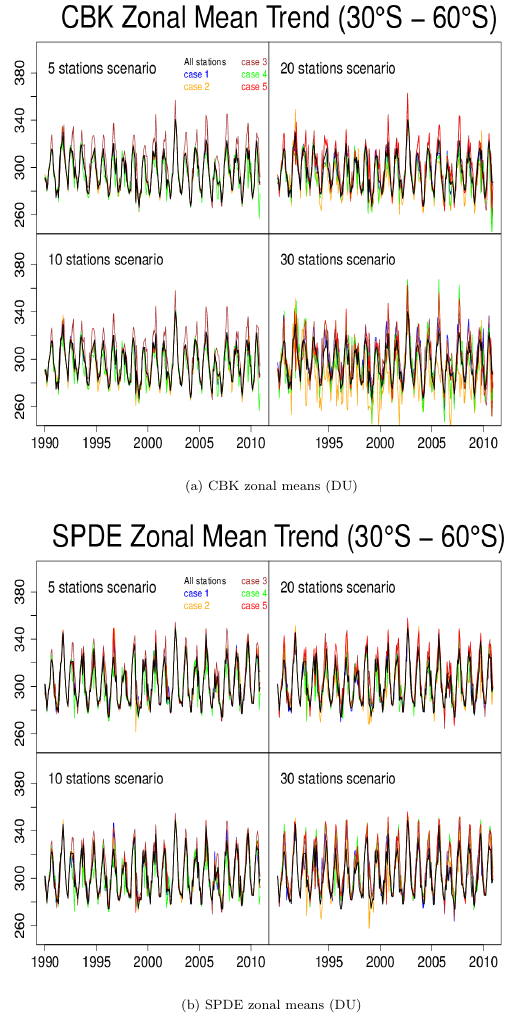
Figure 9. Time series of 30–60 ◦ N zonal means by (a) covariance- based kriging (CBK) and (b) SPDE from 1990 to 2010 for four scenarios with 5, 10, 20 and 30 stations removed globally including 3, 6, 12 and 18 stations removed in the NH.